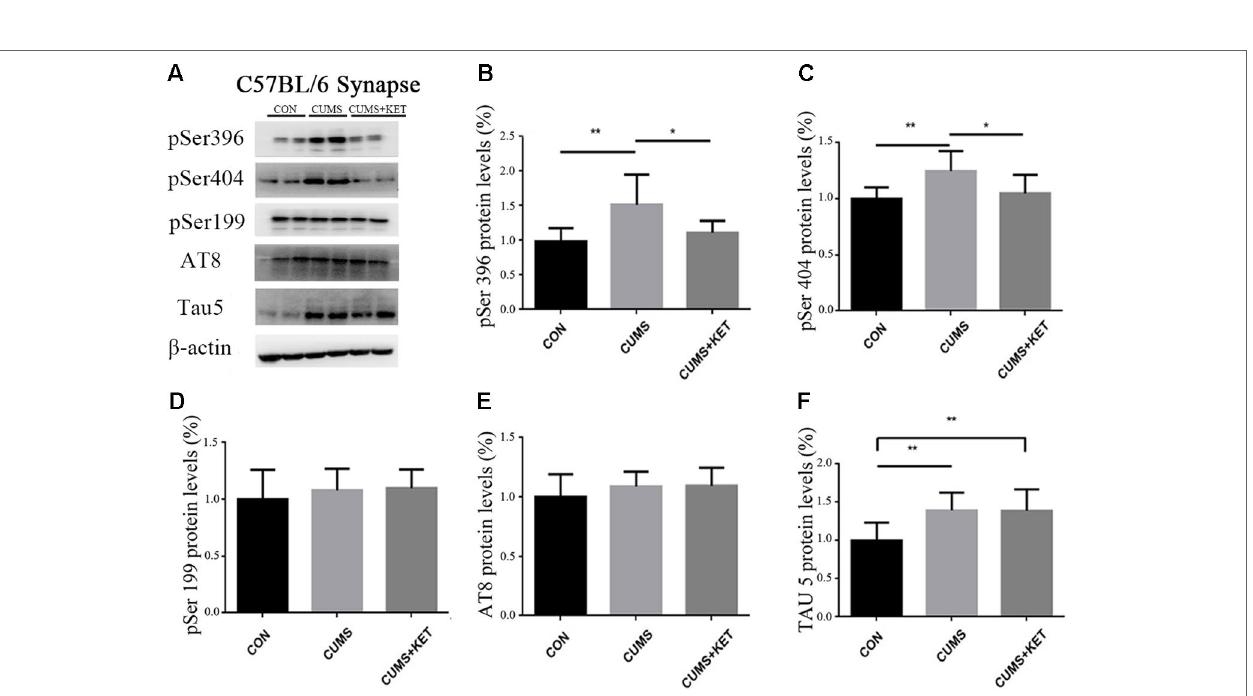
FIGURE 5 | The effects of CUMS and ketamine on Tau protein in the synapses of the hippocampus of C57BL/6 mice. (A) Total Tau and hyperphosphorylated Tau protein in the synapses of the hippocampus. (B, C, and F) After CUMS, the levels of pSer396, pSer404, and total Tau protein increased; ketamine decreased the levels of hyperphosphorylation at pSer396 and pSer404 sites in the synapses, but not total Tau. (D and E) Levels of pSer199 and AT8 did not change after CUMS and ketamine treatment did not alter the levels in the synapses. Data are expressed as mean ± SD; n = 10 per group. One-way ANOVA was used to compare differences among the groups (* p < 0.05, ** p <